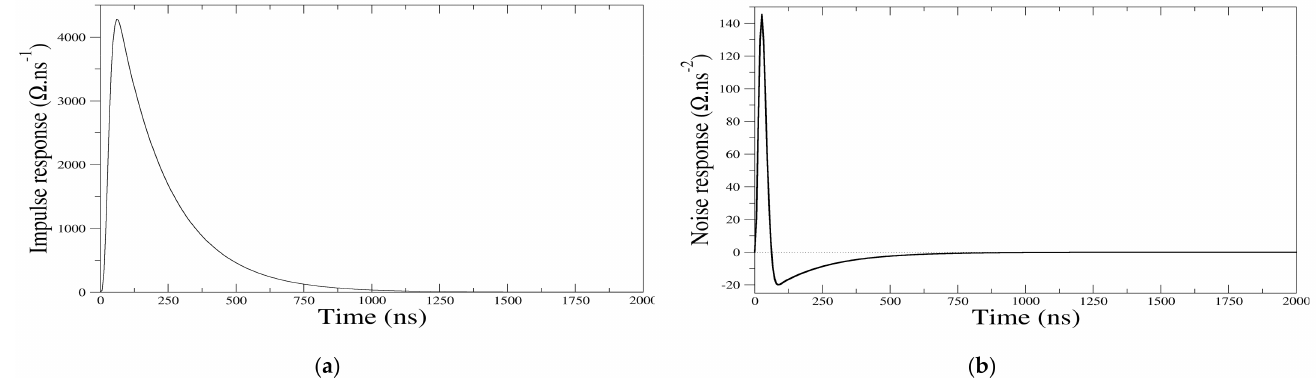
Figure A2. Impulse response functions. ( a ) in V/A/s for signal and “current noise”. ( b ) in V/A/s 2 for “voltage